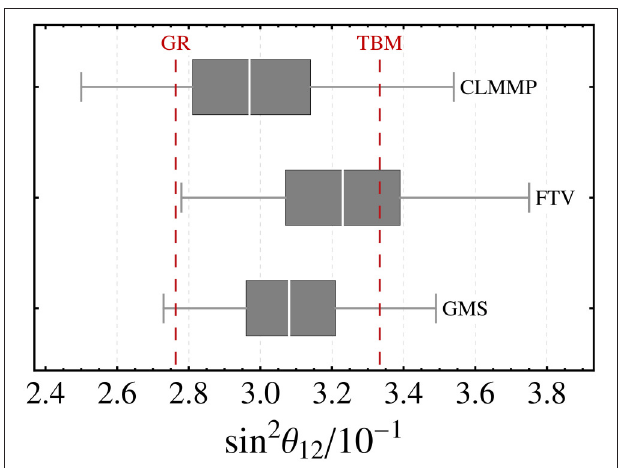
FIGURE 4 | Predictions for sin 2 θ 12 for GR and TBM mixing patterns (red dashed lines); the box charts represent the value of the global fits (for NO only since the allowed region is the same for both orderings) performed in Capozzi et al. [89] (labeled as CLMMP), Forero et al. [90] (labeled as FTV) and Gonzalez-Garcia et al. [91] (labeled as GMS). The white vertical lines inside the boxes are the best fit values, the gray boxes the 1 σ confidence regions and the gray lines the 3 σ allowed regions.